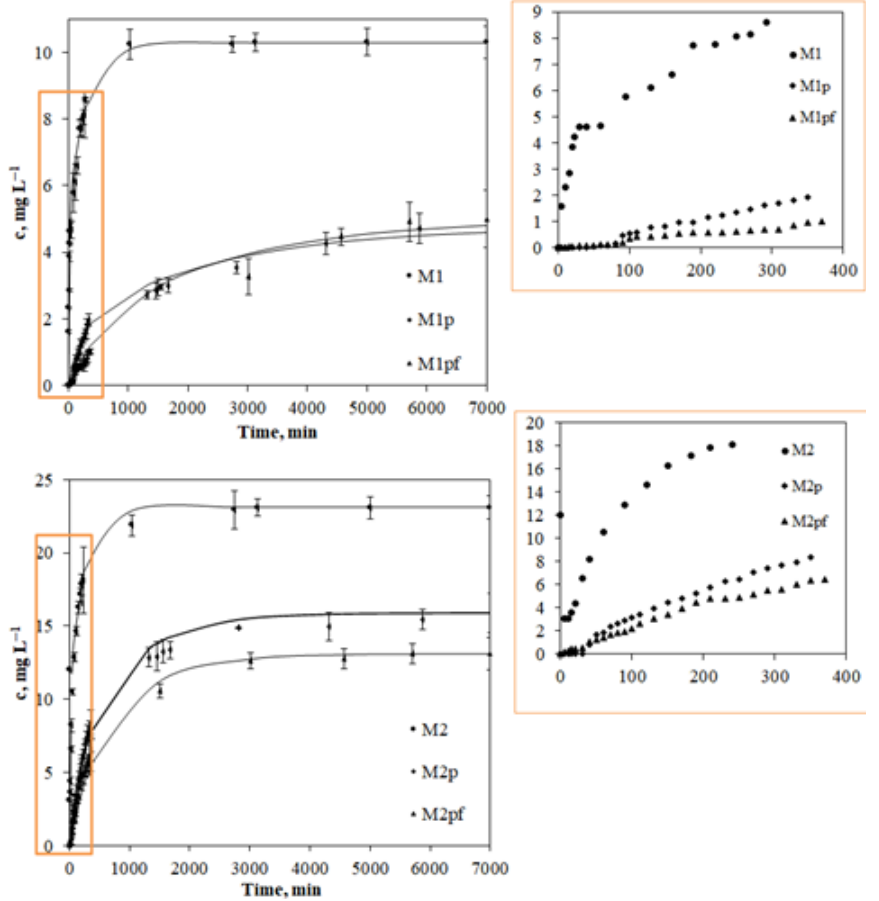
Figure 3. TC-HCl concentration in time for mono- and multilayer membranes: experimental (points) and modeled using the So and Macdonald equation (continuous lines). The inserts represent the experimental data obtained in the first 400